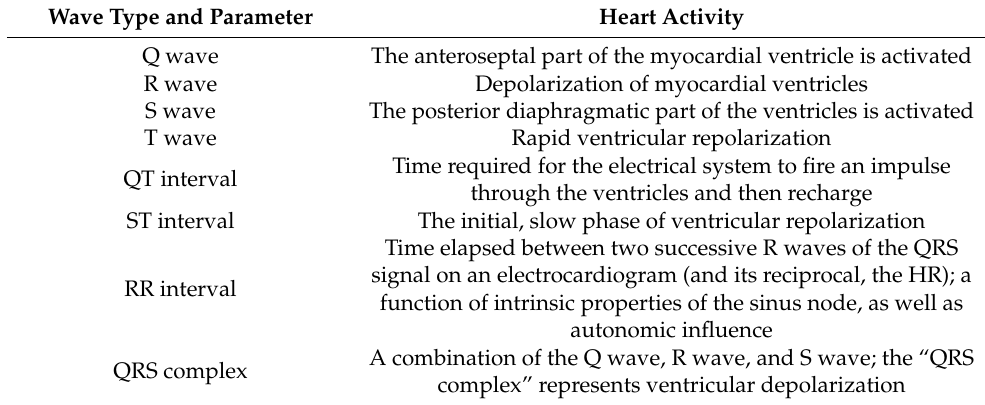
Table 2. ECG signal features and causes of electrical impulses in the heart (based on [41]). Wave Type and Parameter Heart Activity Q wave The anteroseptal part of the myocardial ventricle is activated R wave Depolarization of myocardial ventricles S wave The posterior diaphragmatic part of the ventricles is activated T wave Rapid ventricular repolarization Time required for the electrical system to fire an impulse QT interval through the ventricles and then recharge ST interval The initial, slow phase of ventricular repolarization Time elapsed between two successive R waves of the QRS signal on an electrocardiogram (and its reciprocal, the HR); a RR interval function of intrinsic properties of the sinus node, as well as autonomic influence A combination of the Q wave, R wave, and S wave; the “QRS QRS complex complex” represents ventricular depolarization